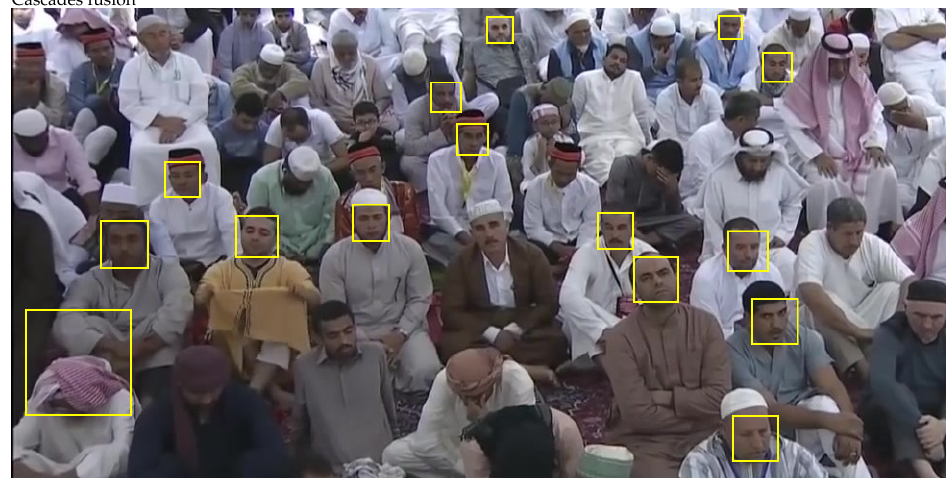
Figure 5. Cascades fusion by overlapping face regions (detected by three cascades).